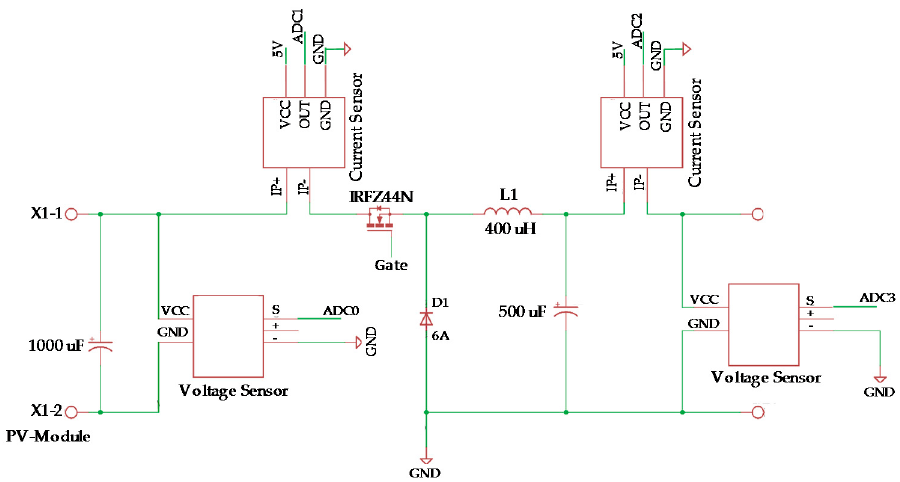
Figure 13. Buck converter with current and voltage sensors.